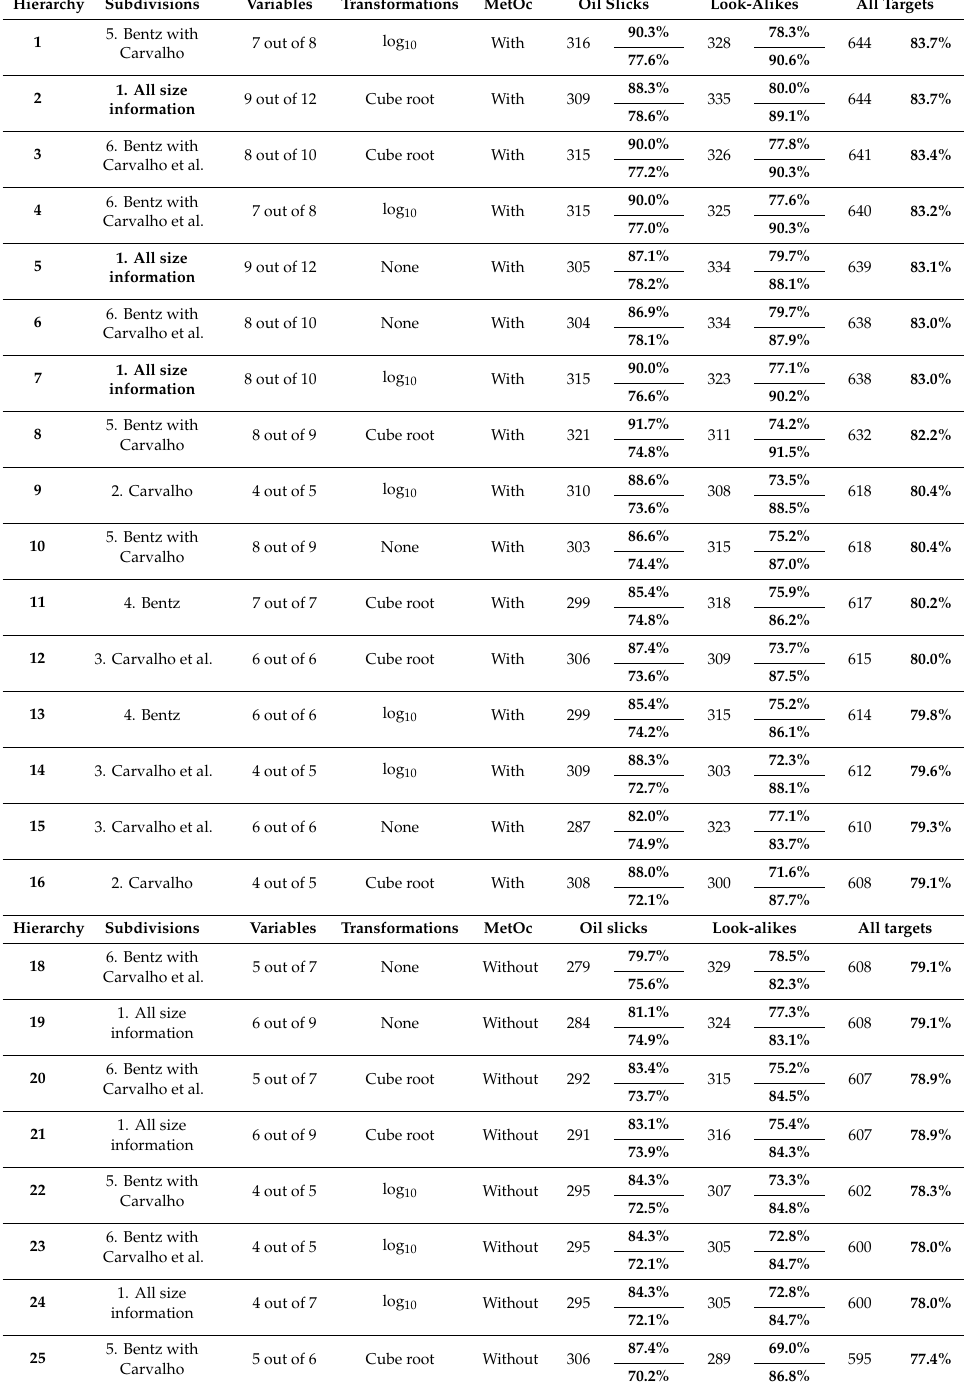
Table 6. Classification accuracies of the 35 di ff erent LDA algorithms. See also Tables 1–5. The plots for the three All size information with MetOc subdivisions (bold) are shown in Figure